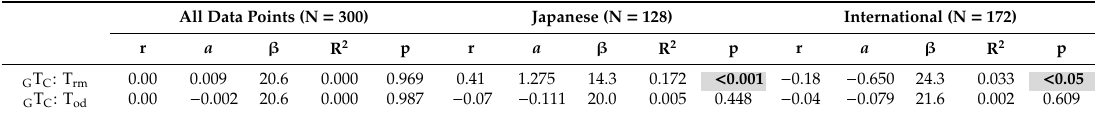
Table 11. Correlation coe ffi cients.